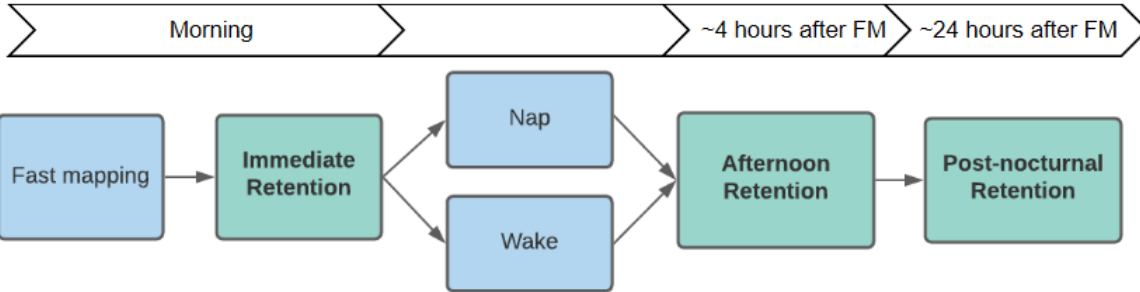
Figure 1. Time Course from Fast Mapping and the Ensuing Retention